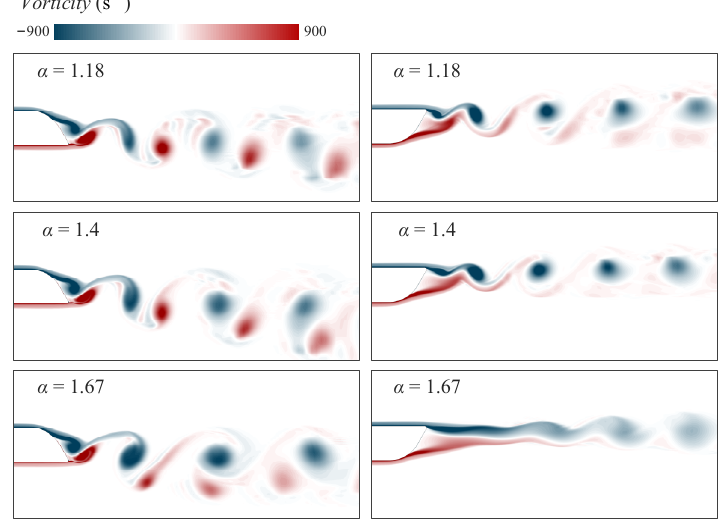
Figure 12. Vorticity contours downstream of the modified hydrofoil under different α.